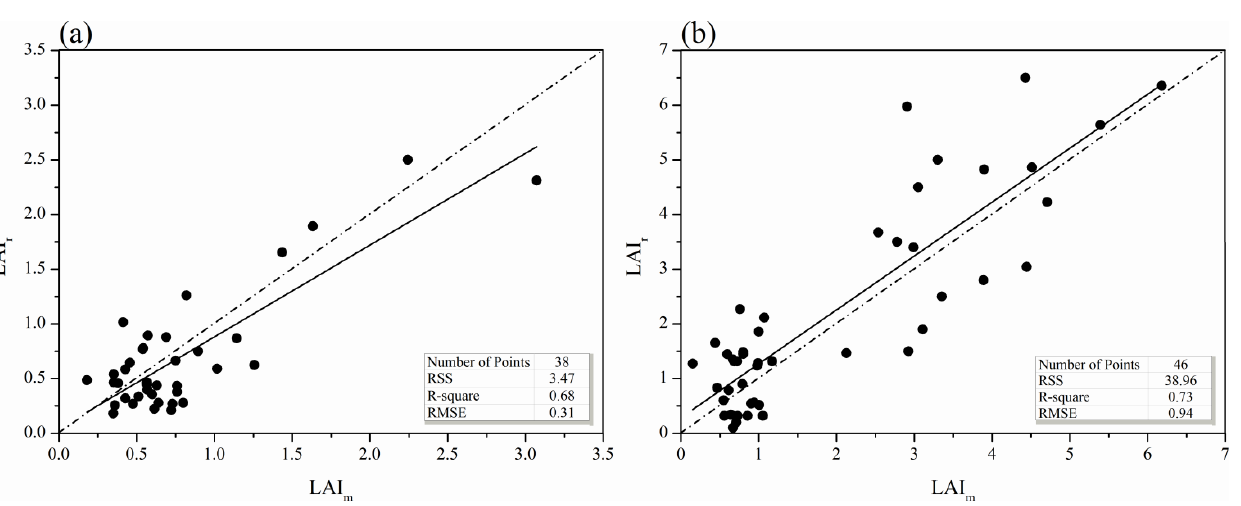
Figure 5. LAI r compared to the field-measured LAI on DOY 177 (July) ( a ) and DOY 233 (August) ( b ) in